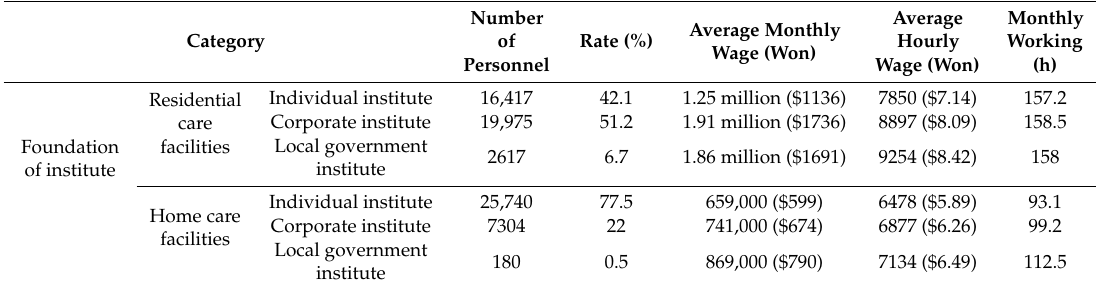
Table 5. Average wage and monthly average working hours based on foundation of institute.